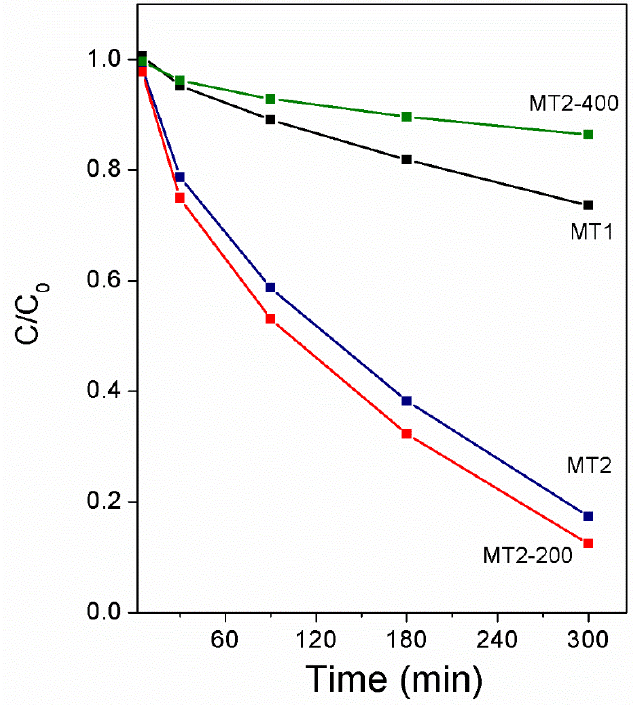
Figure 10. Acid orange 7 (AO7) degradation under visible light, using material (MT1) and all MT2 solids as catalysts. (pH 5, T = 20 ºC, catalyst concentration = 1 g / L). Table 3. Degradation and mineralization percentage of acid orange 7 (AO7) under visible radiation. The experimental conditions were air-equilibrated; pH 5; [AO7] = 20 ppm; and [catalyst] = 1 g / L.